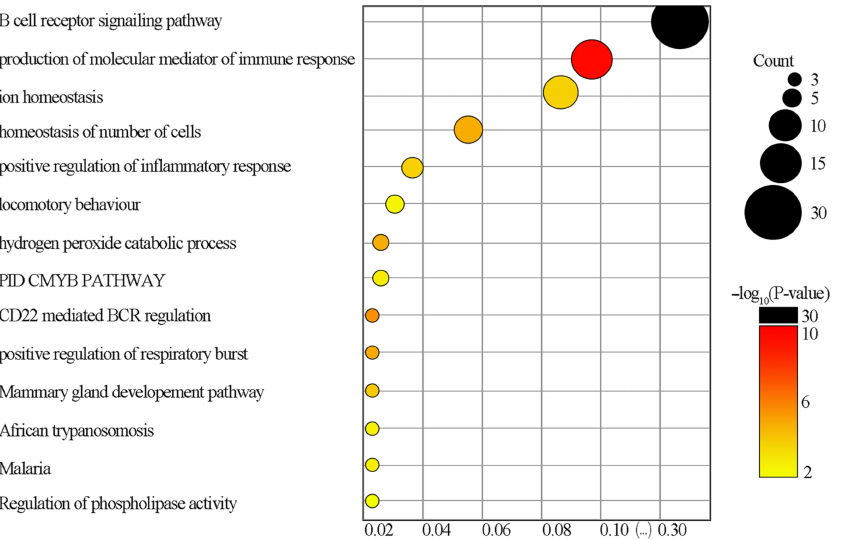
Figure 3. Bubble plot from KEGG enrichment analysis of DEGs comparing children before and after HSCT. The size of the circle corresponds to the amount of genes that belong to the given KEGG pathway, while its color represents the − log 10 of p -value for distinct KEGG pathway.